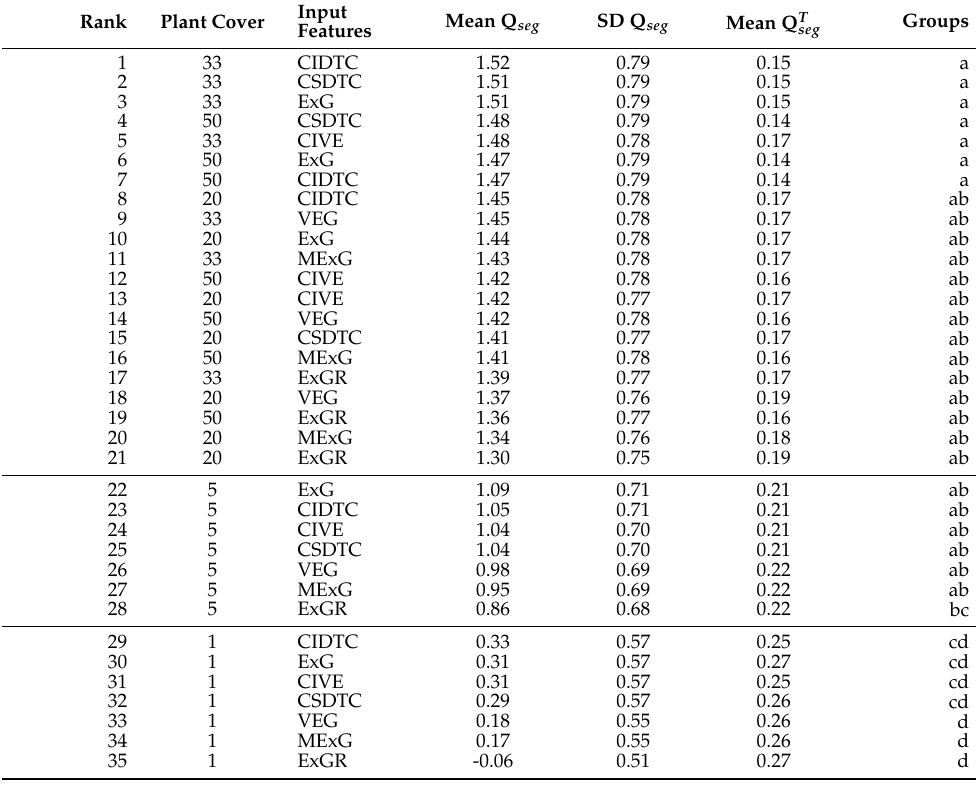
Table 4. Results of Tukey’s HSD pairwise comparison test for all plant cover/input features combi- nations while fixing pixel selection to all pixels (ALL). Table shows mean and standard deviation (sd) of segmentation quality Q seg and mean of logit transformed segmentation quality Q T seg that was used for calculating test statistics and p-values. Models with a shared significance group letter can be denoted as not significantly different. Tested models are single-feature input DTC based on Excess Green (ExG), Color Index of Vegetation Extraction (CIVE), Excess Green minus Excess Red (ExGR), Vegetative Index (VEG) and Modified Excess Green (MExG), furthermore the multi-feature input decision tree classifiers based on 7 color indices (CIDTC) and 18 color channels